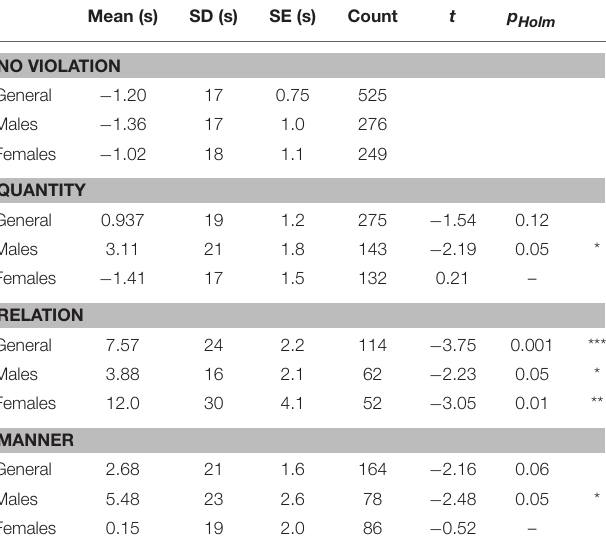
TABLE 2 | Effect of Violations and Gender on 1 d (in seconds).